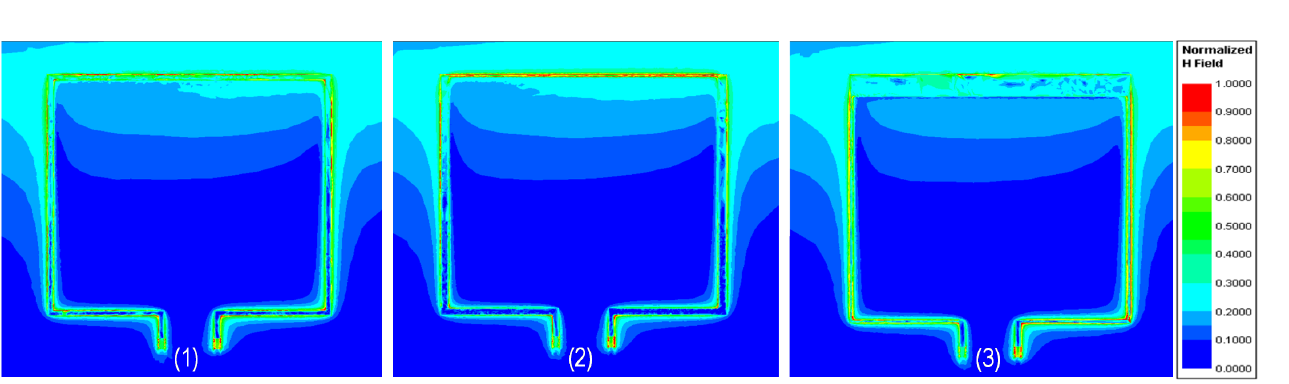
Figure 14. Normalized magnetic field distribution for the simulated test cases in Table 3.